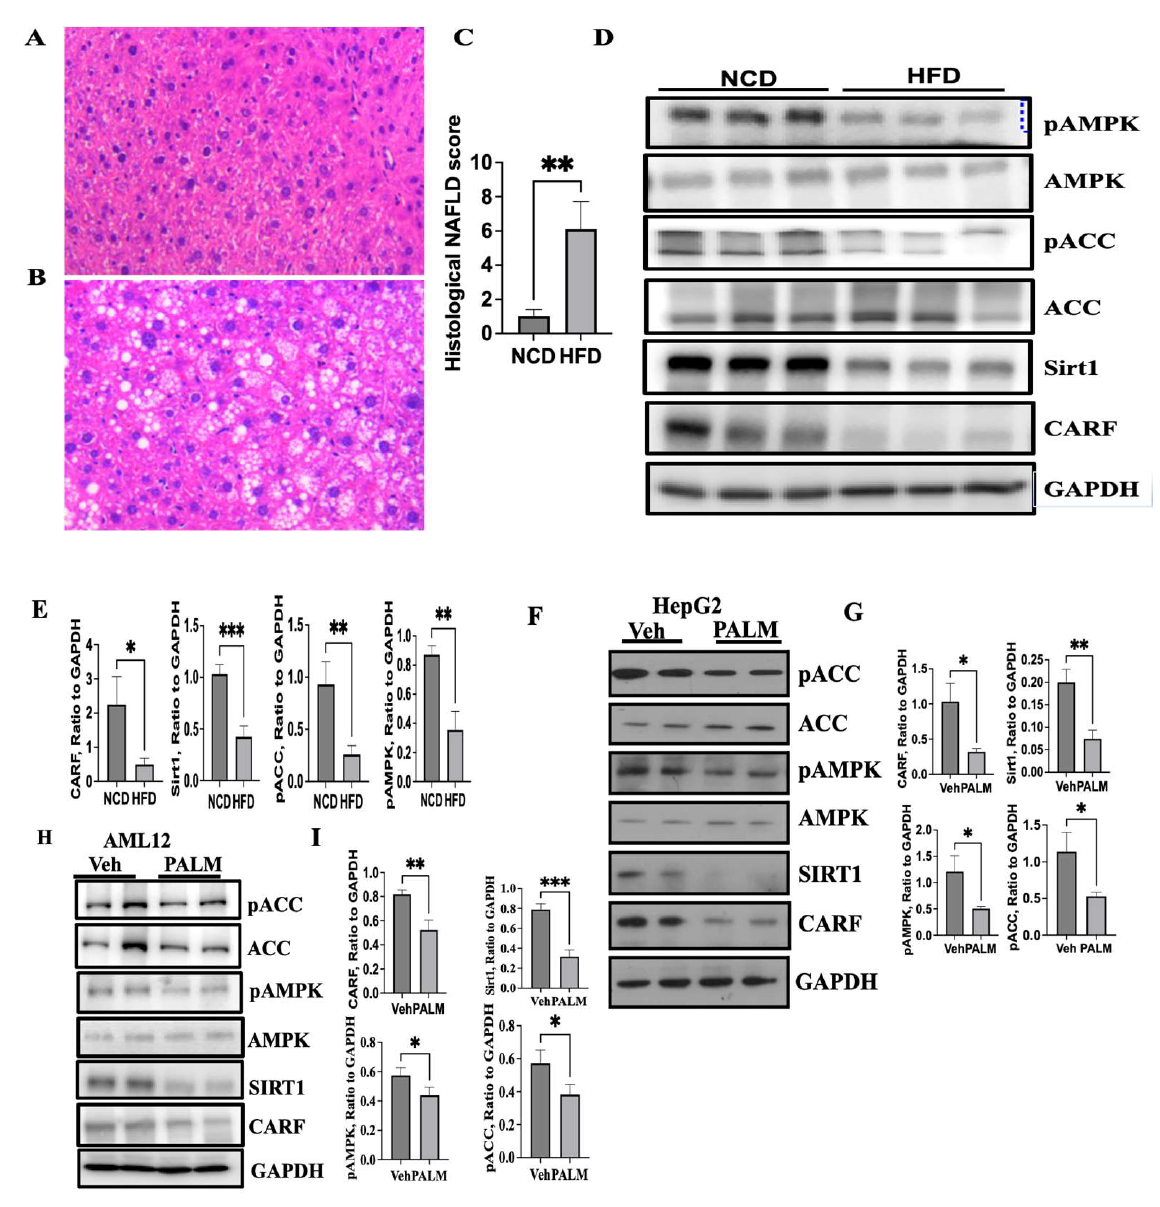
Figure 1. HFD-mediated stress reduces CARF expression in hepatocytes. Representative H&E- stained liver sections from mice ( n = 6) on an HFD showing a higher level of lipid accumulation ( B ) compared to mice on an NCD ( A ). Quantification of NAFLD intensity as revealed by H&E staining of the liver sections. Values are given as mean ± S.E.M., n = 4–5 per group ( C ). Western blotting of liver lysates and its quantification analysis from NCD- and HFD-fed mice ( n = 5–6 per group) shows a decrease in hepatic CARF expression in mice on an HFD compared to NCD-fed mice ( D , E ). Expression of pACC, pAMPK, and Sirt1 are shown as the markers of hepatic steatosis ( D , E ). Western blotting and quantification of band intensities ( n = 3) show the expression of CARF and other markers of steatosis in HepG2 ( F , G ) and AML12 ( H , I ) cells after exposure to 750 µ M palmitate for 24 h (a parametric, unpaired Student’s t -test was used to compare between the two groups, * p < 0.05, ** p < 0.01, *** p < 0.001; H&E-stained images were taken at 20× objective).